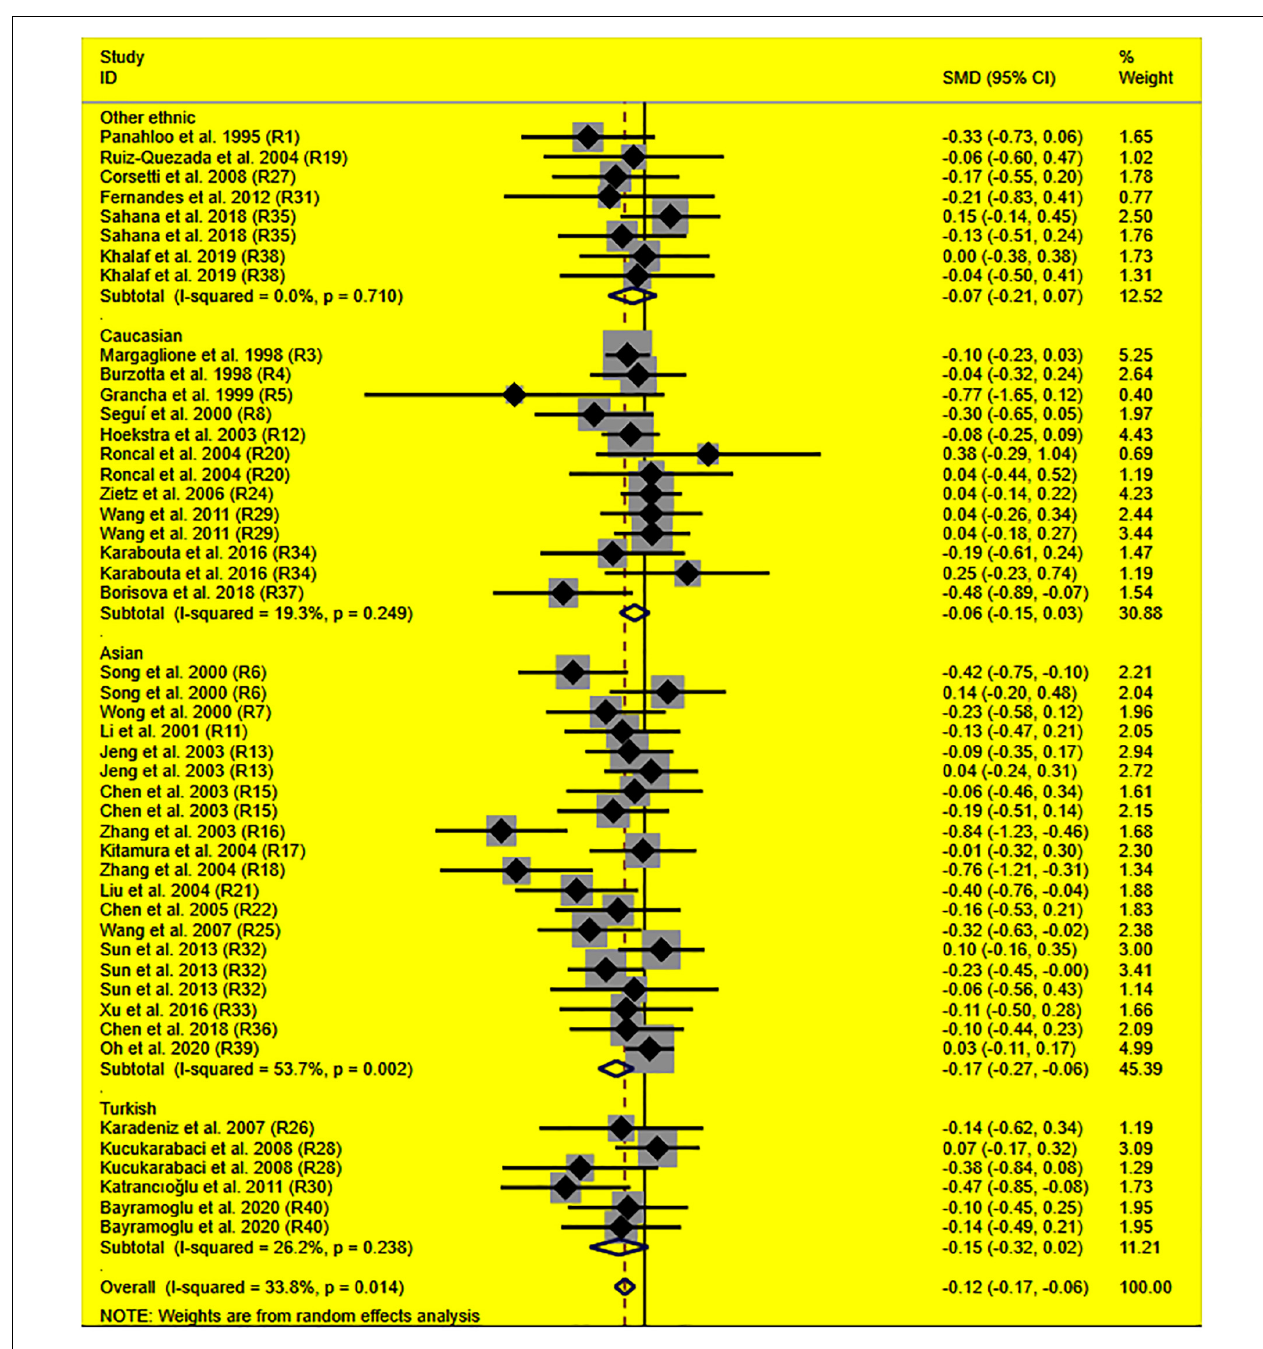
indicating the synthetic results (the analysis data reflect the effect of the rs1799889 variant on lipid profile at total or subgroup level) were robust (refer to Table 2 for more